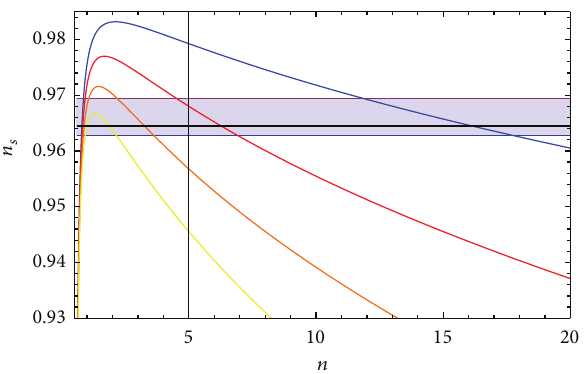
Figure 3: The scalar spectra index versus 𝑛 for four different values of tensor-to-scalar ratio, as 𝑟 = 0 . 05 (blue line), 𝑟 = 0 . 09 (red line), 𝑟 = 0 . 11 (orange line), and 𝑟 = 0 . 14 (yellow